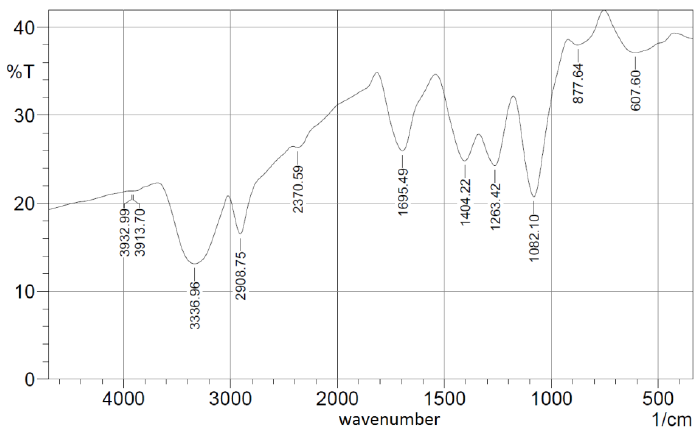
Figure 8. FTIR spectroscopy pattern of crosslinked PVA with embedded ceria NPs.